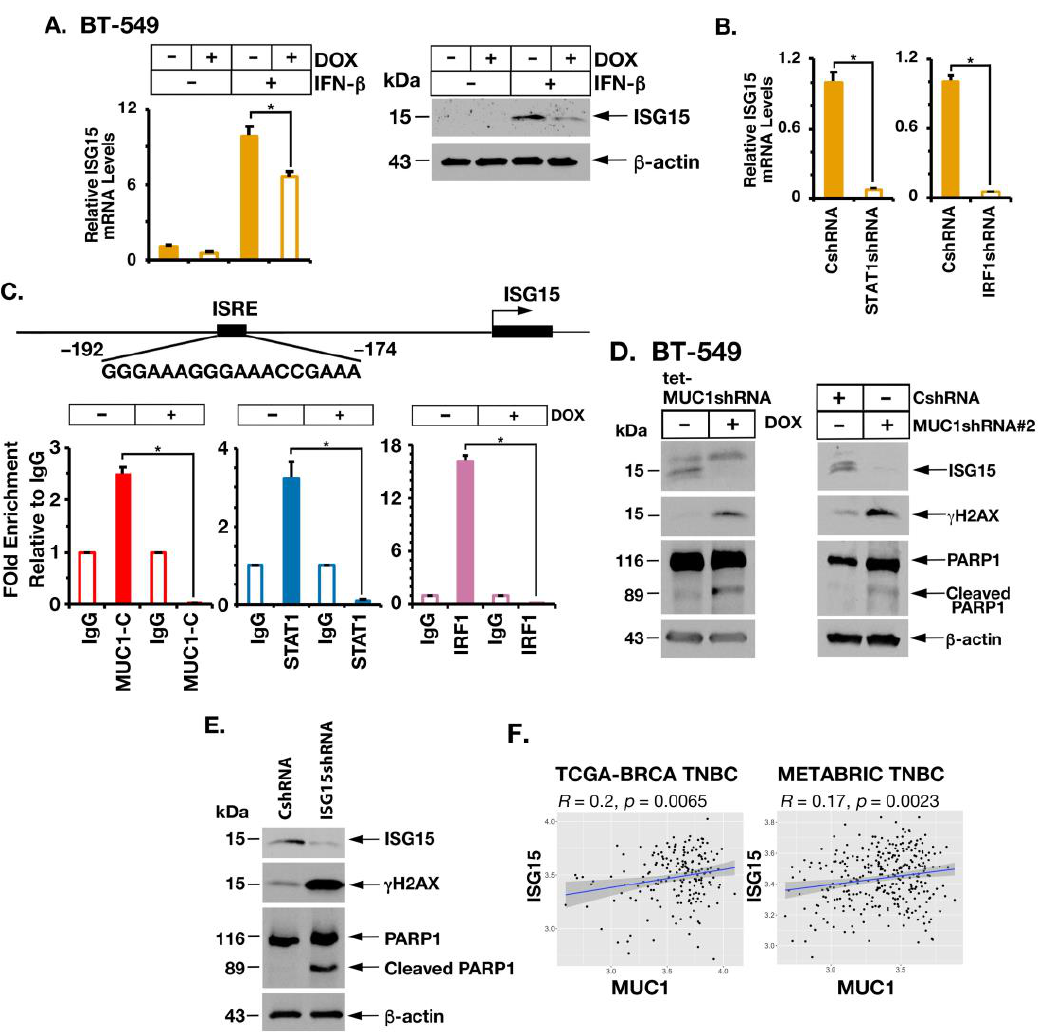
Figure 6. Silencing MUC1-C downregulates ISG15 expression and induces the DNA damage re- sponse. ( A ) BT-549/tet-MUC1shRNA cells treated with vehicle or DOX for 7 days and stimulated with IFN- β for 24 h were analyzed for ISG15 mRNA levels by qRT-PCR ( left ). The results (mean ± SD of 4 determinations) are expressed as relative mRNA levels compared to that obtained for vehicle-treated cells (assigned a value of 1). Lysates were immunoblotted with antibodies against the indicated proteins ( right ). ( B ) BT-549 cells expressing a CshRNA, STAT1shRNA or IRF1shRNA were analyzed for ISG15 mRNA levels by qRT-PCR. The results (mean ± SD of 4 determinations) are expressed as relative mRNA levels compared to that obtained for vehicle-treated cells (assigned a value of 1). ( C ) Schema of the ISG15 promoter region with highlighting of the ISRE. Soluble chro- matin from BT-549/tet-MUC1shRNA cells treated with vehicle or DOX for 7 days was precipitated with a control IgG, anti-MUC1-C, anti-STAT1 and anti-IRF1. The DNA samples were amplified by qPCR with primers for the ISG15 promoter region. The results (mean ± SD of 3 determinations) are expressed as fold enrichment relative to that obtained with the IgG control (assigned a value of 1). ( D ) Lysates from (i) BT-549/tet-MUC1shRNA cells treated with vehicle or DOX for 7 days ( left ) and (ii) BT-549/CshRNA and BT-549/MUC1shRNA#2 ( right ) were immunoblotted with antibodies against the indicated proteins. ( E ) Lysates from BT-549 cells expressing a CshRNA or ISG15shRNA were immunoblotted with antibodies against the indicated proteins. ( F ) Scatter plots showing correla- tions of MUC1 with ISG15 in TNBCs from the TCGA-BRCA ( left ) and METABRIC ( right ) cohorts. The asterisk (*) denotes a p -value < 0.05. Uncropped Western Blots can be found at supplemental original